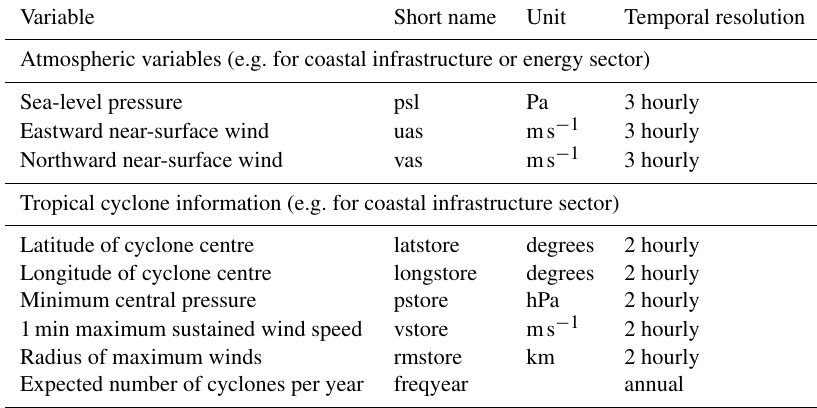
Table 2. Sub-daily GCM data (not bias-adjusted) and tropical cyclone information provided within ISIMIP2b.